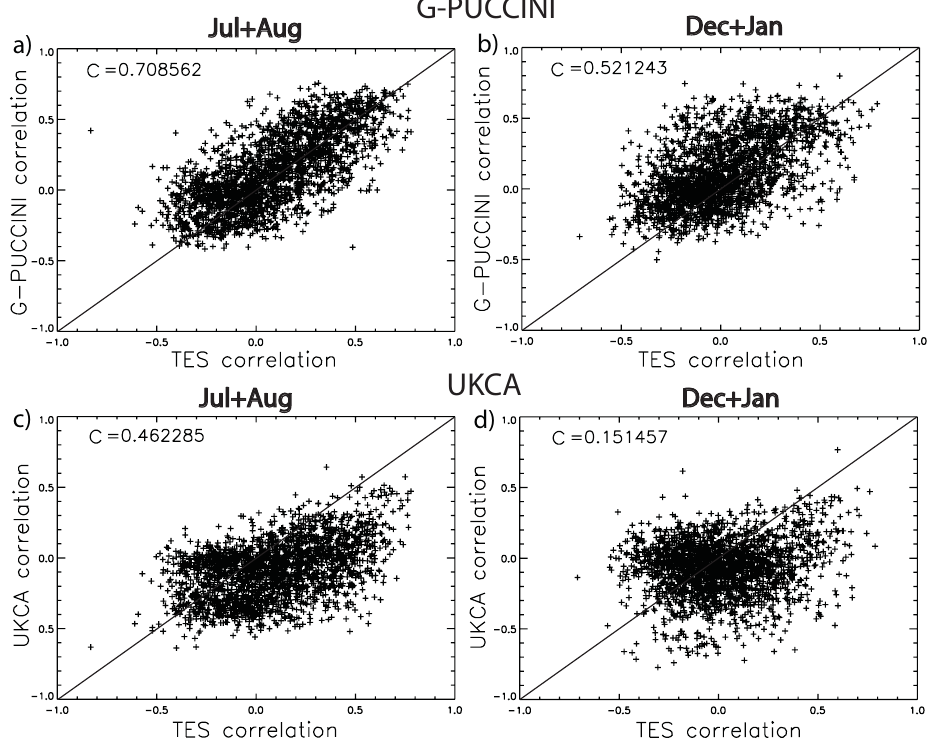
Fig. 5. Scatter plots of modeled versus observed O 3 -CO correlations for July–August (a, c) and December–January (b, d) . The data that have been used are the same as for Fig. 3, and have undergone the same